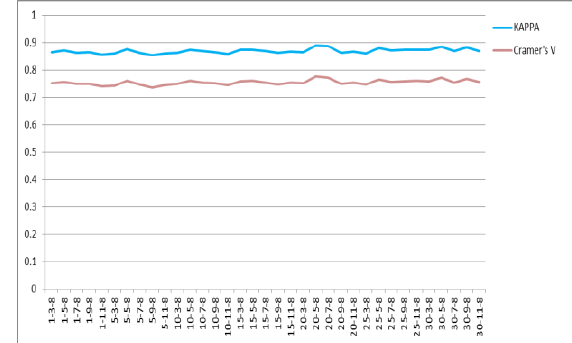
Figure 5. The graph of KAPPA and Cramer 's V